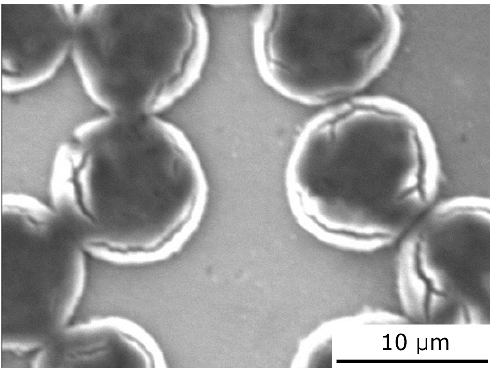
Figure 12. SEM image of the Mg4Li/Granoc composite.